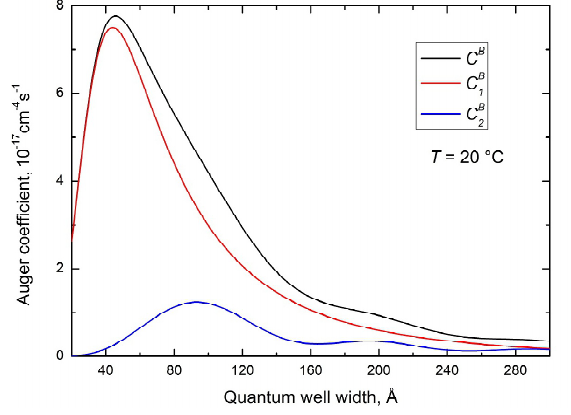
B , and C B on QW 1 2